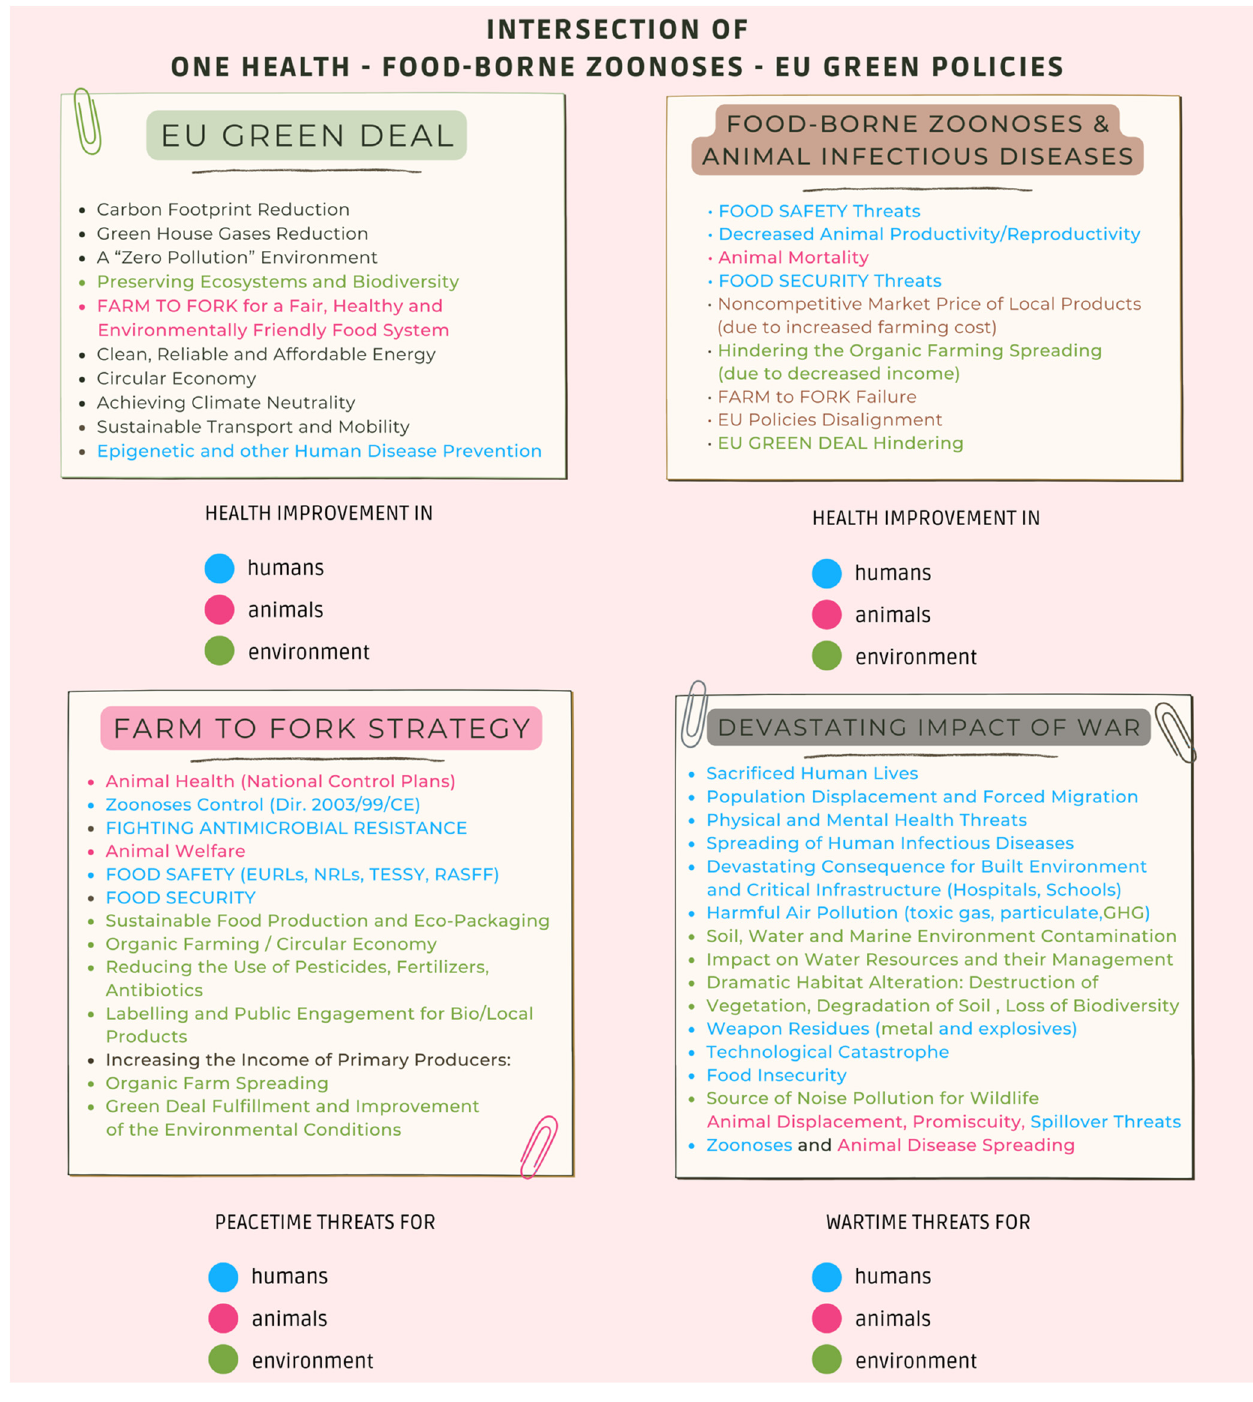
Figure 1. One Health improvements deriving from EU green policies in comparison with peacetime and wartime threats.